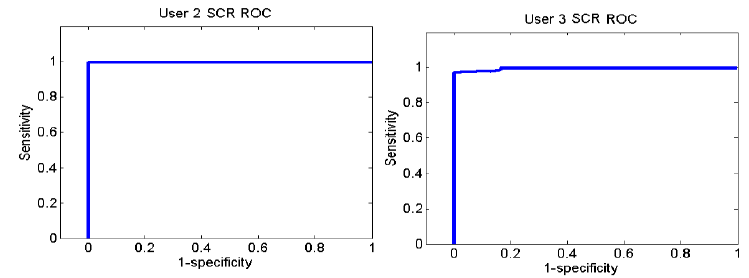
Figure 30. ROC curve of users 2 and 3 from Sounds Test.